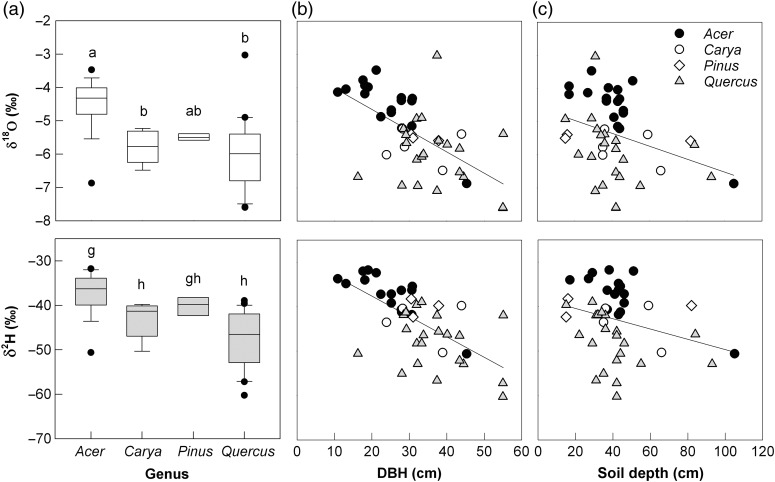
(a) Boxplot of xylem water δ18O (top) and δ2H (bottom) compositions for genera sampled during dry sample dates. Upper and lower boundaries of box denote 75th and 25th percentile ranges, respectively, with median at center line. Error bars show maximum and minimum range of data with points for observations exceeding 1.5 times the interquartile range. Letters denote statistically significant differences (genus differences in δ18O, P < 0.0001; δ2H, P < 0.00001; Acer, n = 13; Carya, n = 5; Pinus, n = 3; Quercus, n = 17). (b) Scatter plot of tree DBH and tree water δ18O (top) and δ2H (bottom) compositions for individuals sampled on dry dates (δ18O, P < 0.00001, R2 = 0.35, y = −0.063x − 3.37; δ2H, P < 0.000001, R2 = 0.42, y = −0.46x − 28.45). (c) Scatter plot of soil depth at tree locations and tree water δ18O (top) and δ2H (bottom) compositions for individuals sampled on dry dates (δ18O, P < 0.05, R2 = 0.09, y = −0.020x − 4.57; δ2H, P < 0.05, R2 = 0.07, y = −0.12x − 38.1).